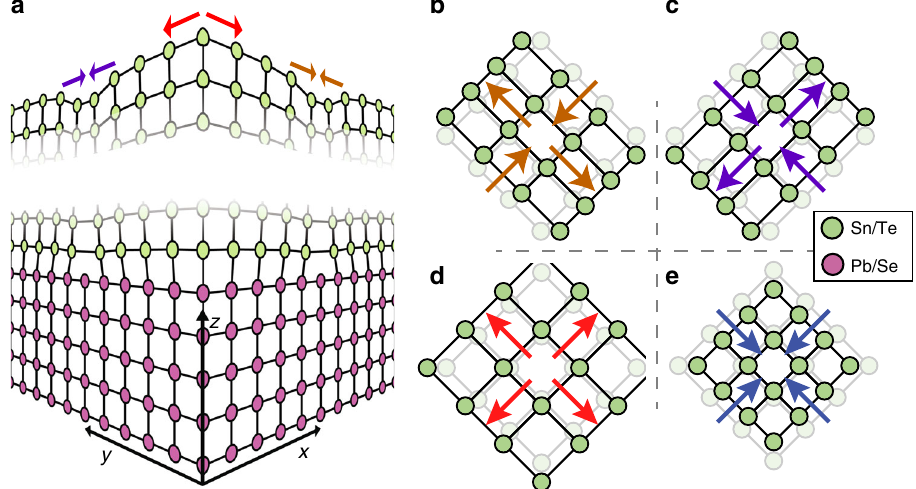
Fig. 1 Different types of strain. a Schematic of the mis fi t dislocation network appearing at the interface between the PbSe (001) substrate (purple) and the SnTe fi lm (green). Lattice distortions in the topmost SnTe fi lm in the presence of b uniaxial compression along x -axis, c uniaxial compression along y -axis, d biaxial tensile strain and e biaxial compressive strain. The color of arrows in b – e indicates the position on the sample in